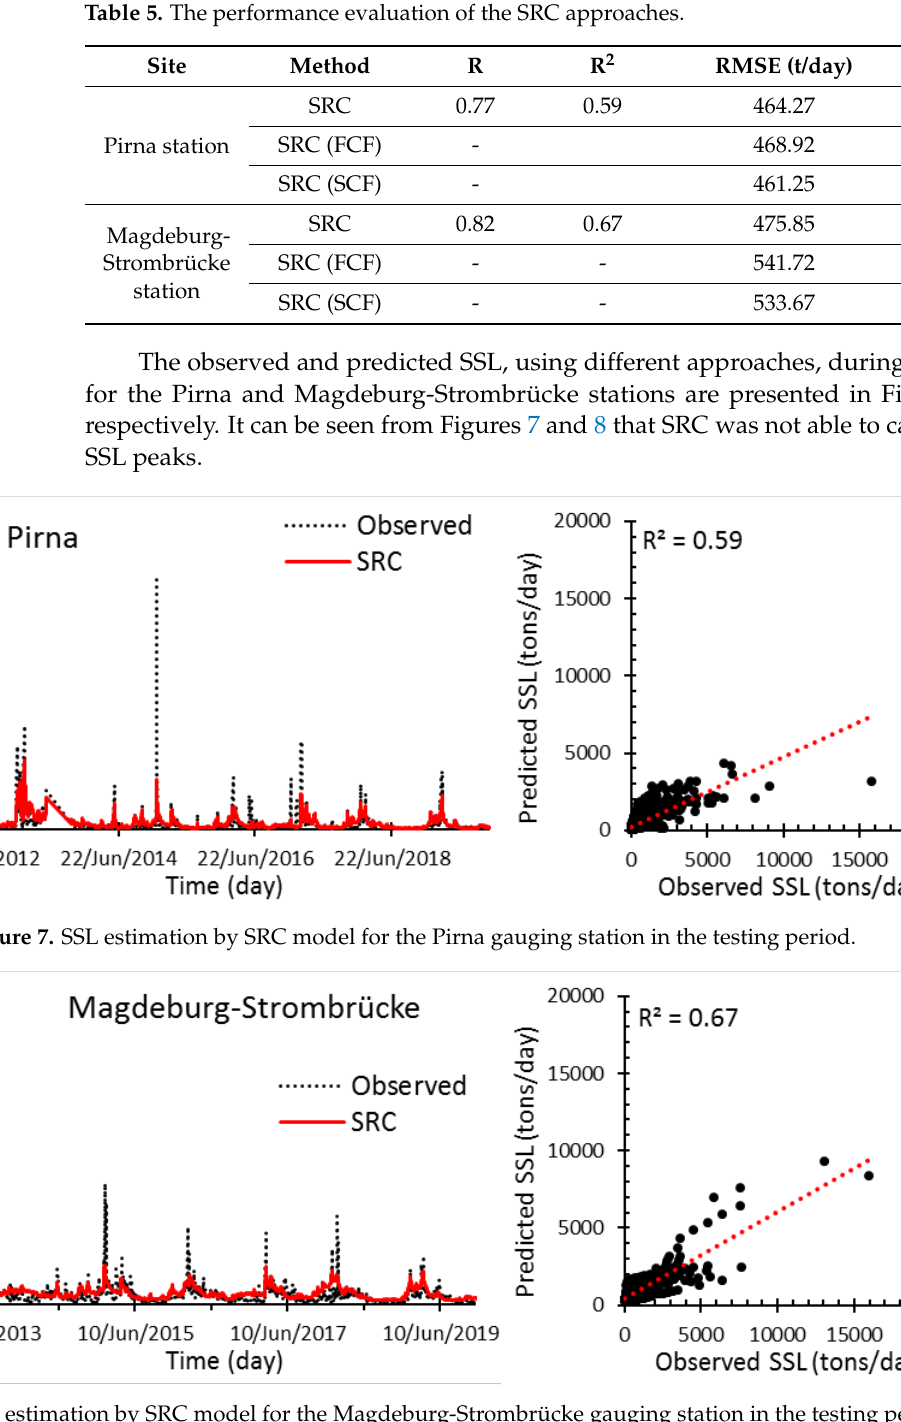
Figure 8. SSL estimation by SRC model for the Magdeburg-Strombrücke gauging station in the testing period.